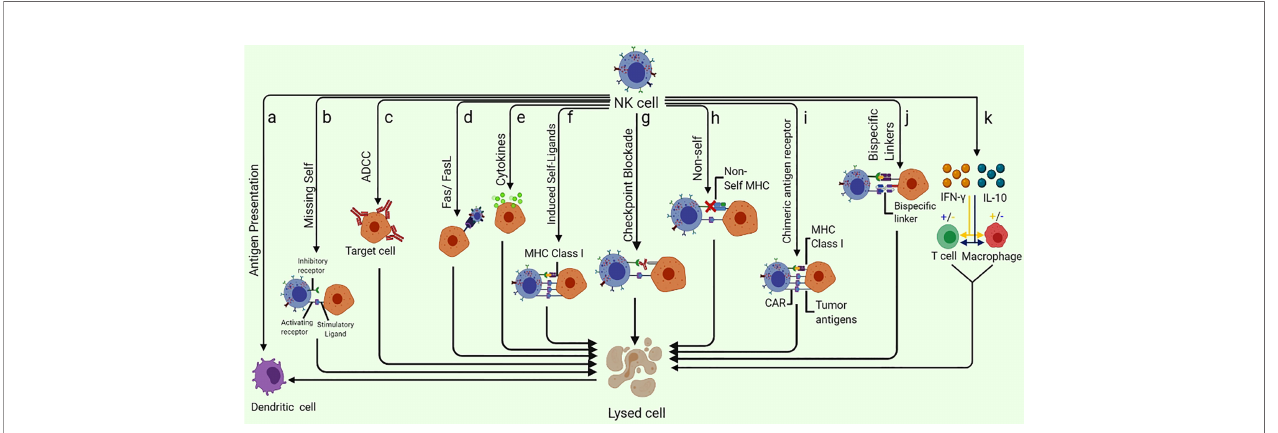
FIGURE 1 | Different ways of NK-cell mediated tumor killing and immune system modulation: (A) NK cells are capable of enhancing the antigen presentation to T cells by killing the immature DC while promoting the IFN- g and TNF- a mediated maturation of DC. (B) NK cells can speci fi cally recognize the cells that lack the expression of self-MHC class I molecules (Missing-self). (C) ADCC can kill the target cell. (D) Fas/FasL pathway is a very effective NK cell-mediated cell killing as the binding of FasL to Fas results in delivering a “ death signal ” to the target cell that undergoes apoptosis shortly. (E) Cytokine pathway can exert anti-tumor potential as Cytokines such as NK cells secret several cytokines such as TNF- a . (F) NK cell receptors NKG2D are capable of recognizing the “ induced-self ” ligands that are express at a very high rate in response to the activation of tumor-associated pathways. (G) Checkpoint blockade may inhibit NK cell suppression by preventing the interaction of NK cell inhibitory receptors with their ligands. (H) As a result of adoptive NK cells transfer, the mismatch between donor and recipient, inhibitory KIRs, NK cells eliminate the allogeneic tumor cells that lack self-MHC. (I) CAR-NK cells designed speci fi cally to target overexpressed tumor antigens are also useful in eliminating the speci fi c tumor cells. (J) Speci fi cally designed bispeci fi c molecules are also being utilized to speci fi cally eliminate tumor cells as these special molecules bind to activating NK cell receptors on one arm and tumor antigens on the other. (K) NK cells can enhance or diminish macrophage and T cell activities via IFN- g and IL-10